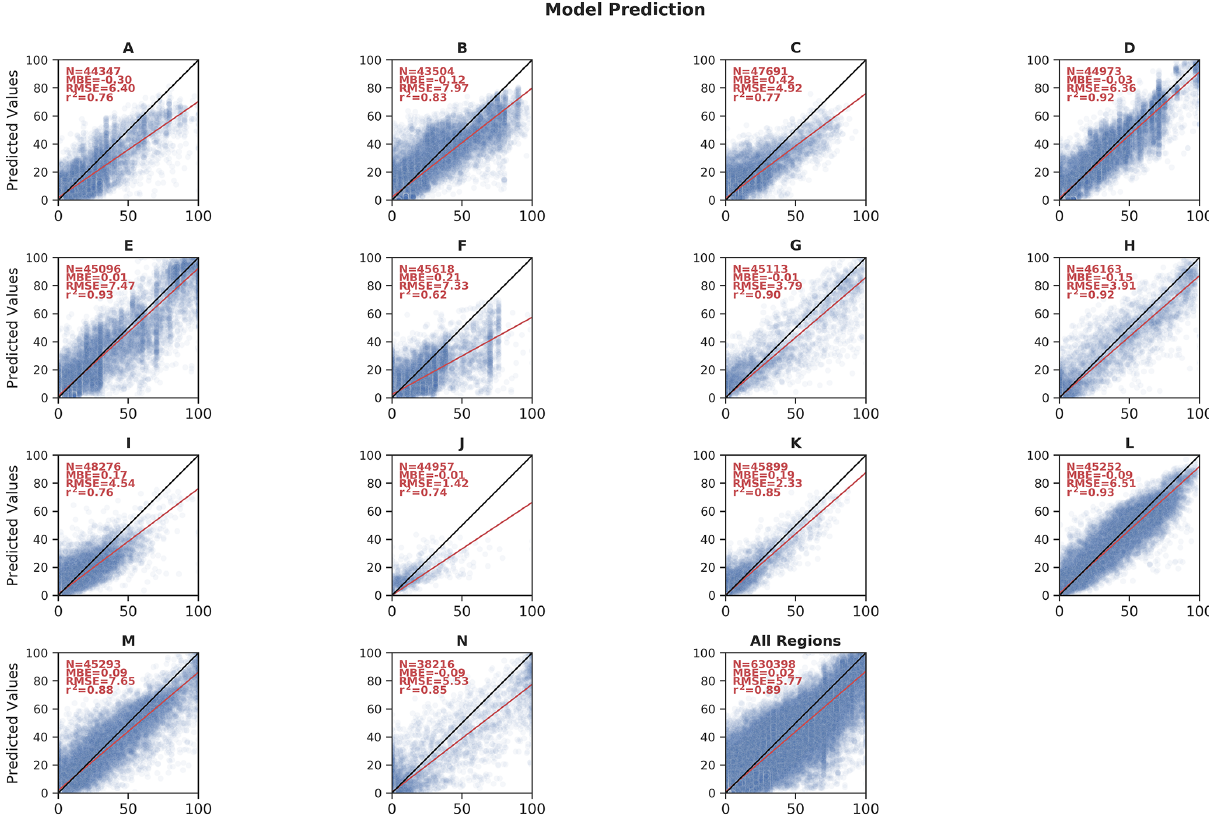
Figure A3. Scatterplots of full model Peat-ML-predicted peatland extent and peatland extent from the peatland training datasets over the 14 BLOO CV